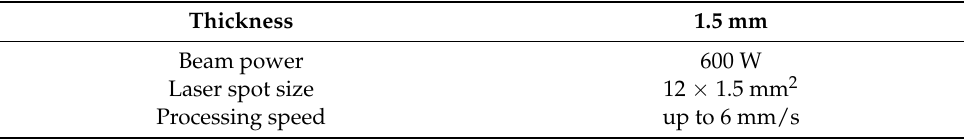
Table 2. Conditions for laser annealing of aluminum